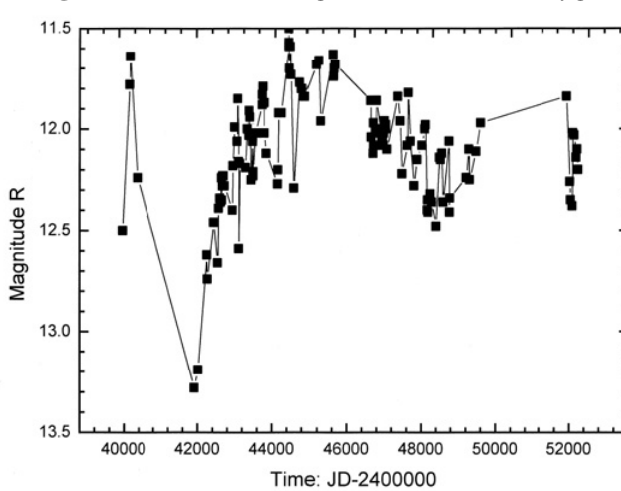
Fig. 7. Pre-whitened light curve of V644 Cyg.